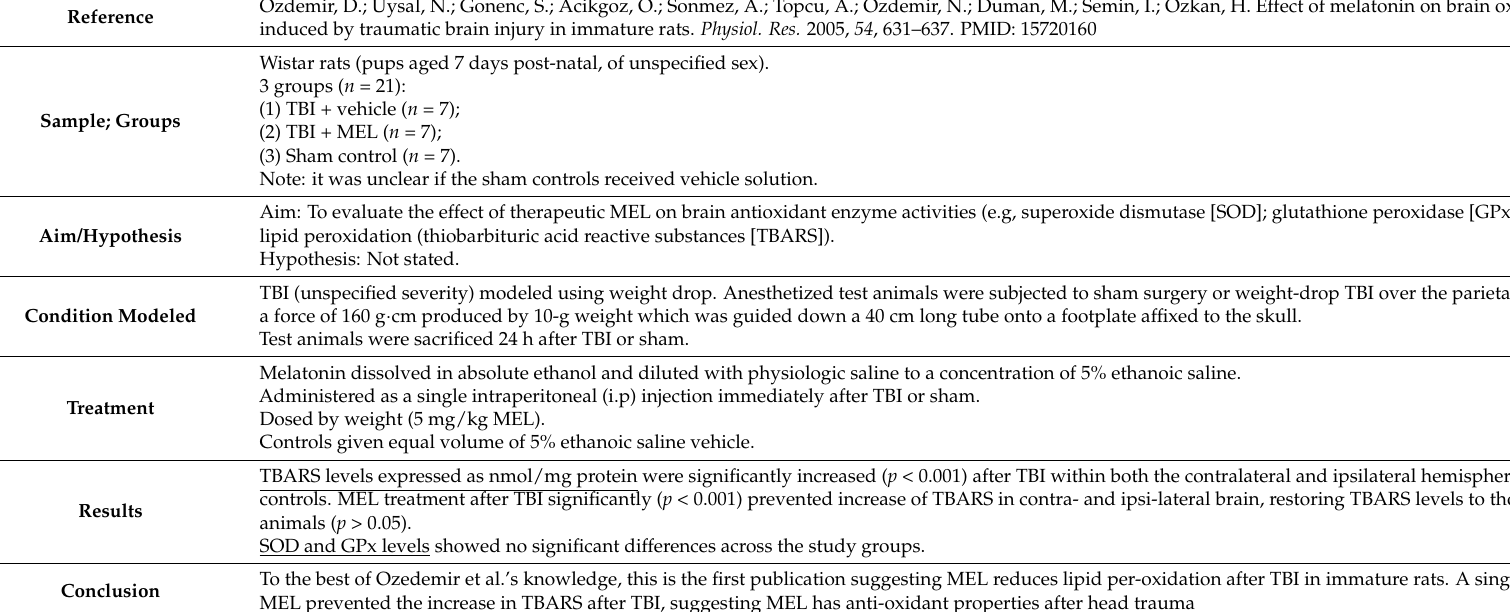
Table A5. Ozdemir et al. (2005) Study